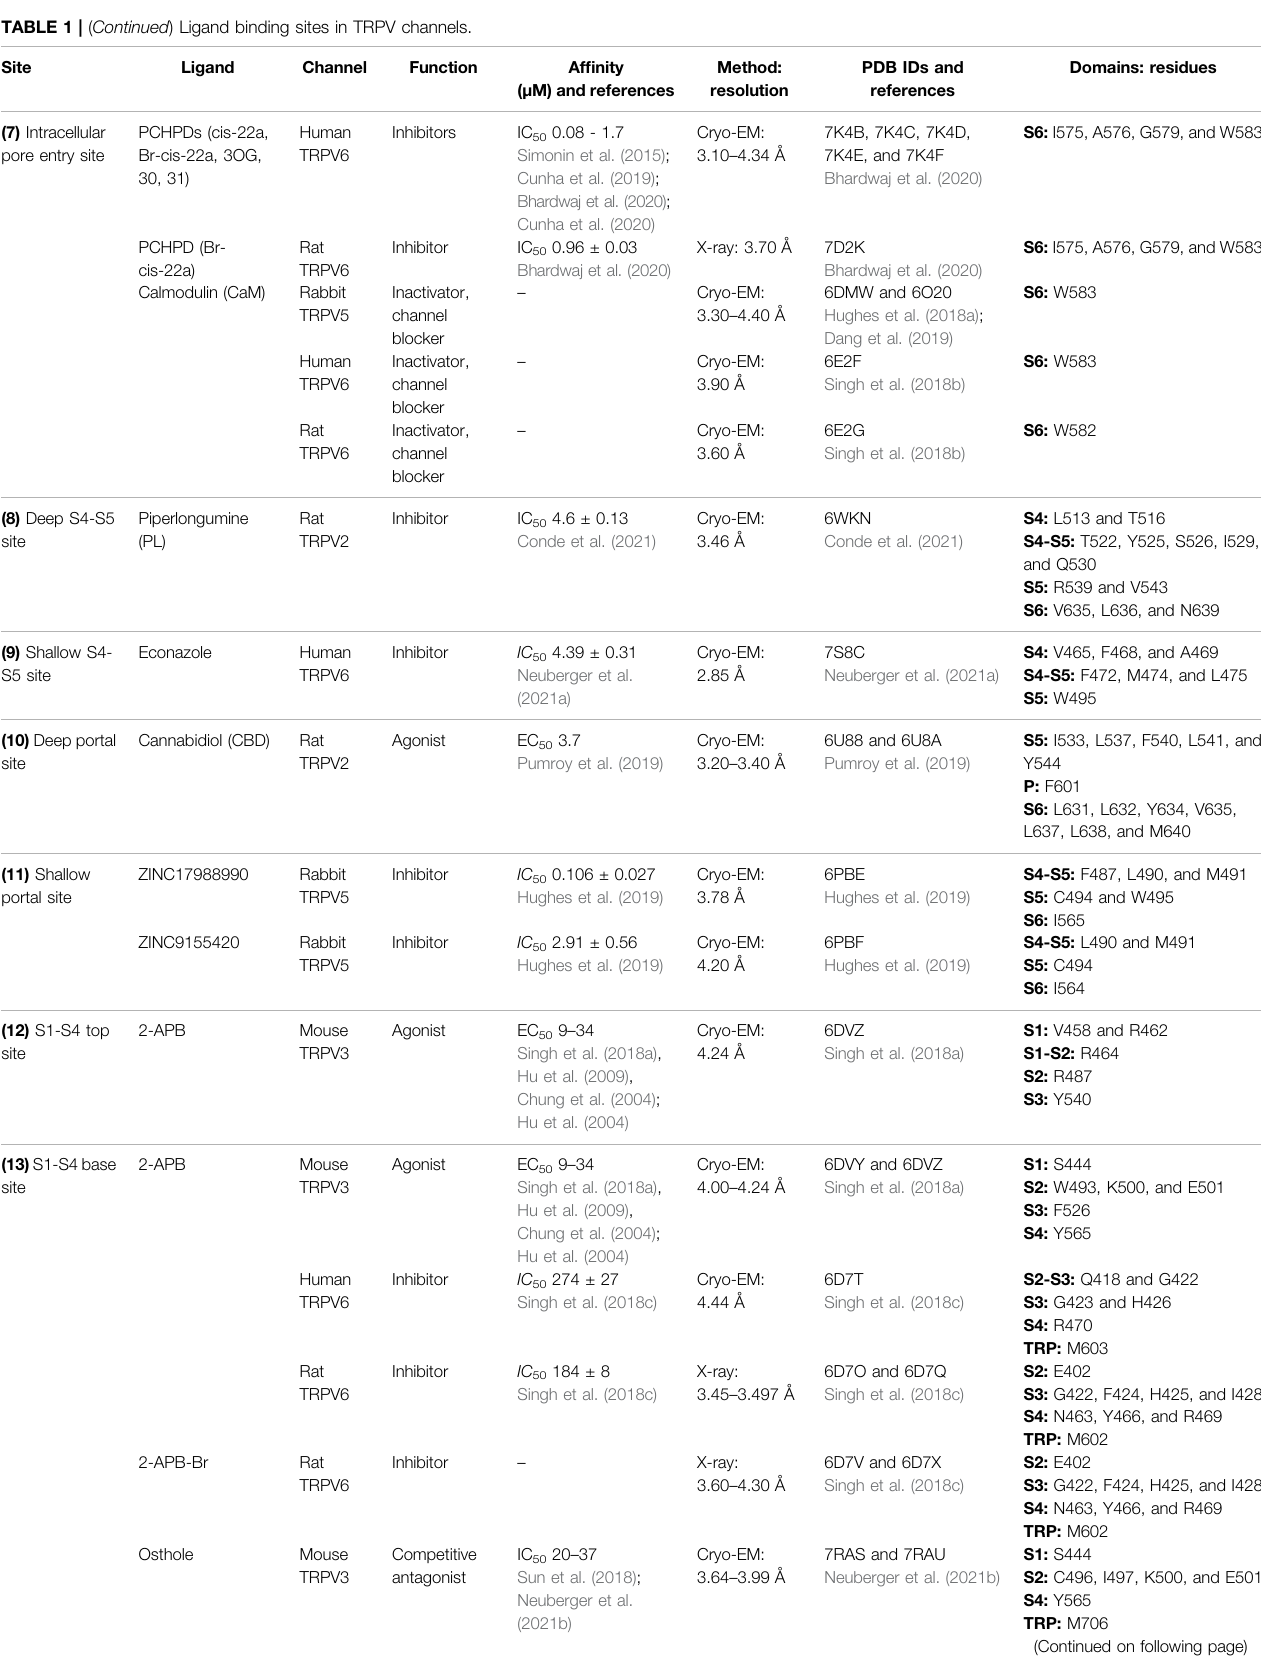
TABLE 1 | ( Continued ) Ligand binding sites in TRPV